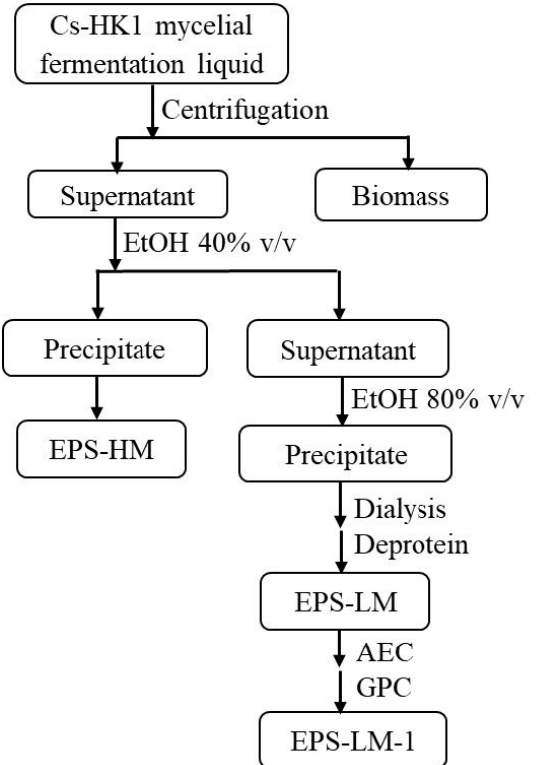
Figure 6. Experimental procedure for the isolation of EPS from Cs-HK1 mycelial fermentation by two-step ethanol (EtOH) precipitation and further fractionation and purification to attain EPS-LM-1 (AEC: anion exchange chromatograph; GPC: gel permeation